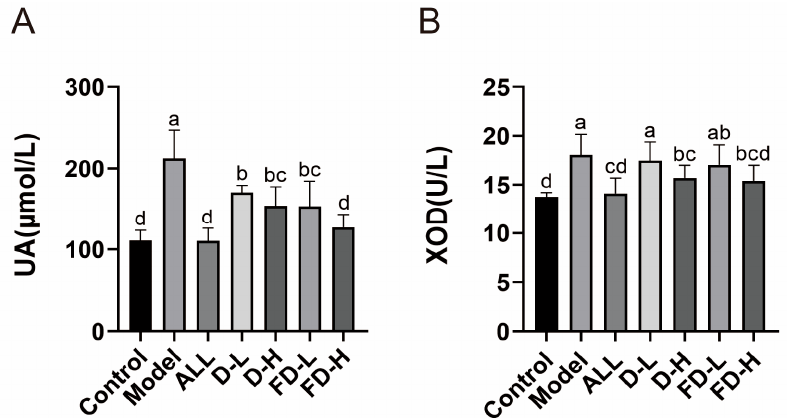
Figure 2. Effects of fermented dandelion on serum UA and XOD in mice with HUA. ( A ) Serum UA level. ( B ) Serum XOD activity. The data are expressed as mean ± SD (n = 8). Different lowercase letters indicate statistically significant differences ( p < 0.05) between the groups. ALL, allopurinol; D-L, dandelion low dose group; D-H, dandelion high dose group; FD-L, low dose group of LAFD; FD-H, high dose group of LAFD.